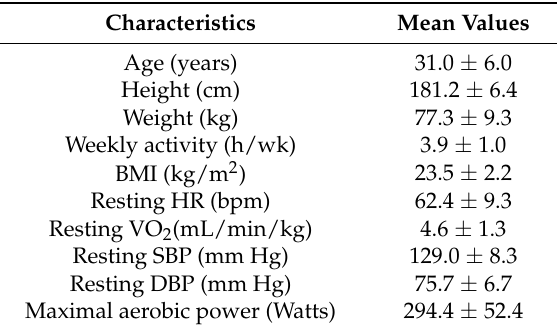
Figure 1. CONSORT flowchart. Table 1. Participants’ characteristics after inclusion.